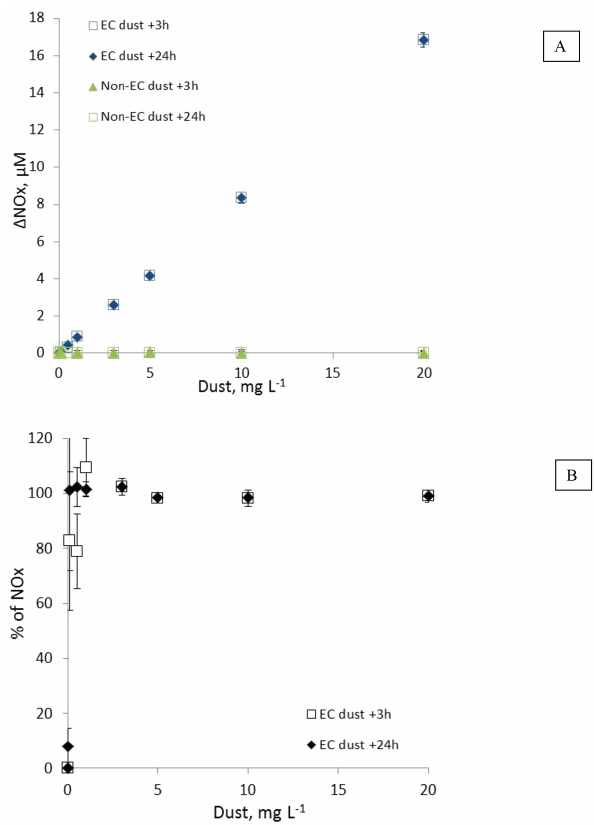
Figure 6. Results of abiotic dissolution experiments: (A) 1 NO x ( [ NO x ] after the introduction of dust −[ NO x ] initial ) in µM relative to the amount of dust (EC and non-EC dust) introduced in seawater for contact times of 3 and 24h, and (B) percentage of NO x released from EC dust (NO x % = 1 NO x × 100 /N total dust ) as a function of the dust amount introduced in seawater for contact times of 3 and 24h. Data represent the average and standard deviations of the three